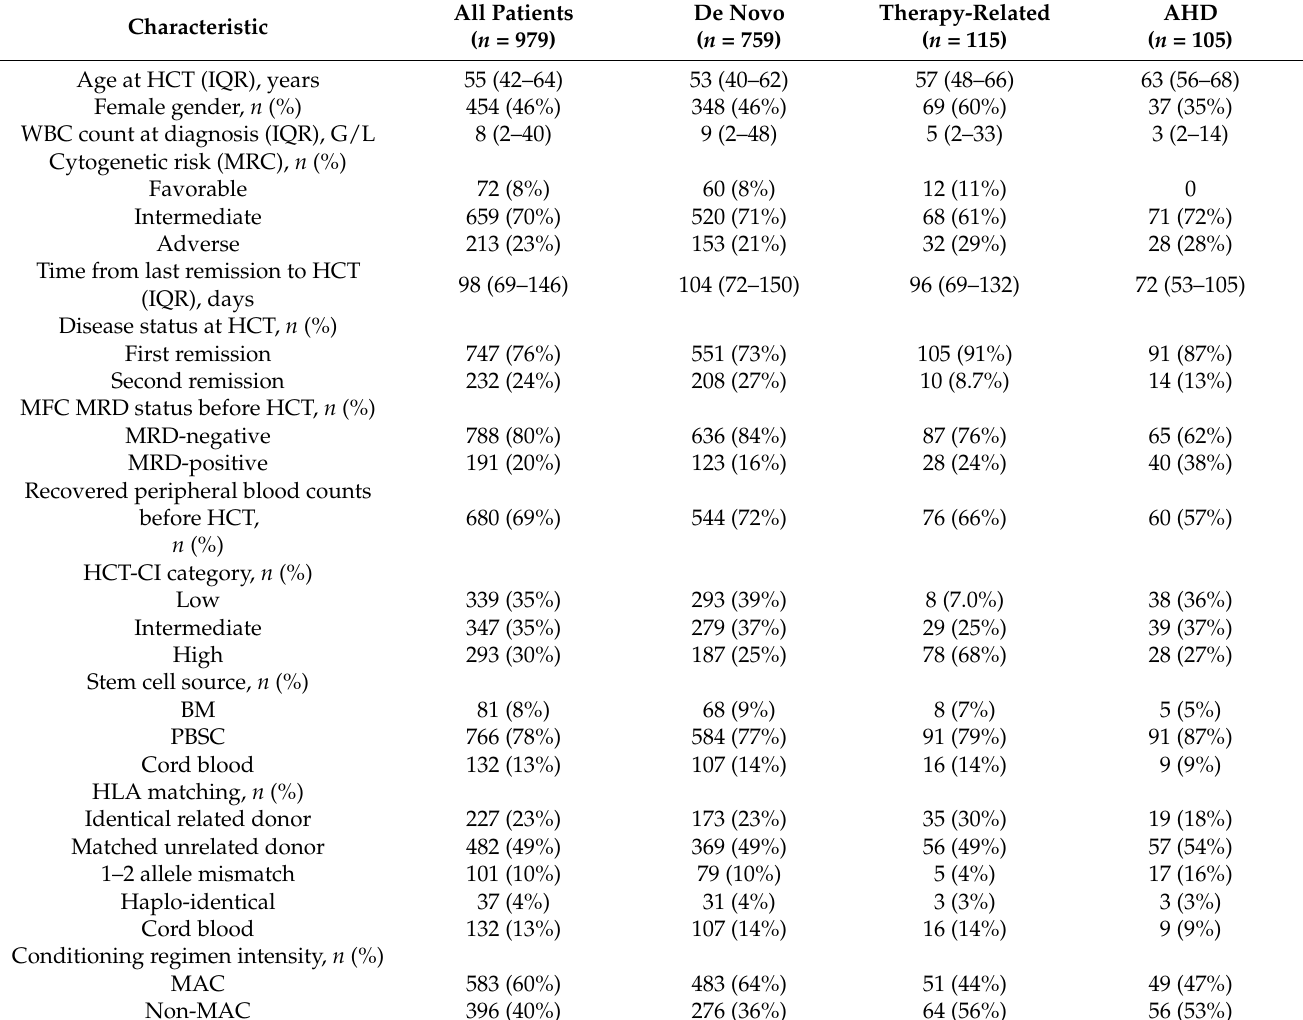
Table 1. Pre-HCT demographic and clinical characteristics of study cohort ( n = 979), stratified according to disease status at diagnosis (de novo vs. therapy-related vs. after antecedent hematologic disorder